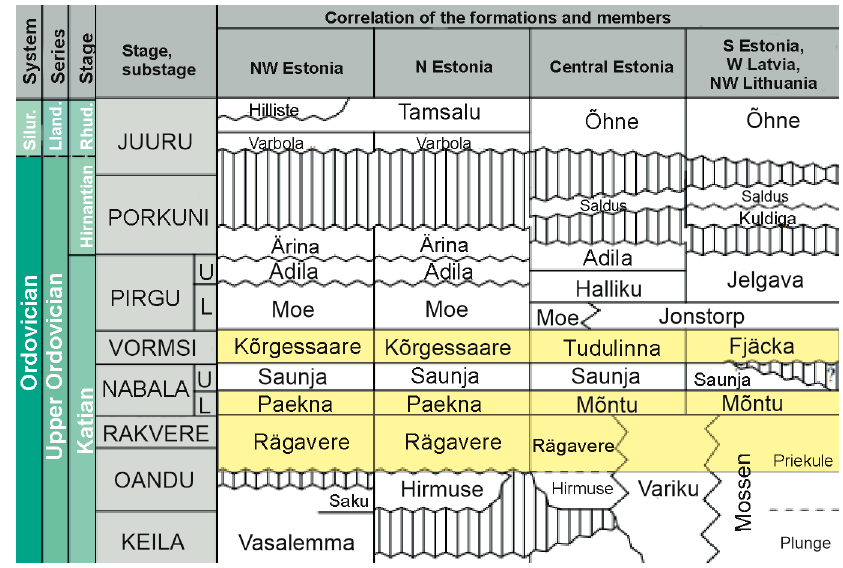
Fig. 3. Stratigraphic correlation of the studied strata (edited from Meidla et al. 2014). Analysed stratigraphic units are highlighted. Abbreviations : Silur. – Silurian, Lland. – Llandovery, Rhud. – Rhuddanian, U – Upper, L – Lower, NW – Northwest, N – North, S – South, W –